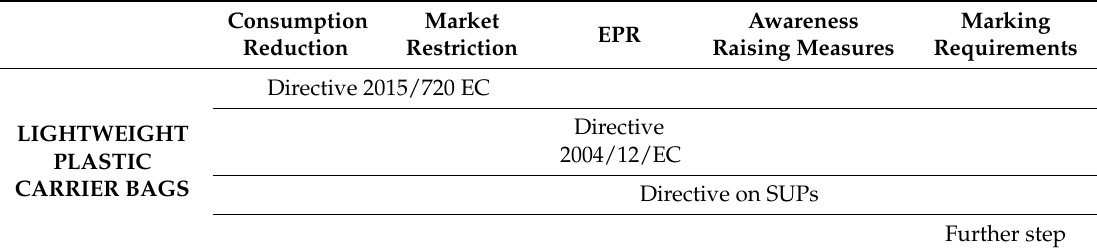
Table 2. Actions for lightweight plastic carrier